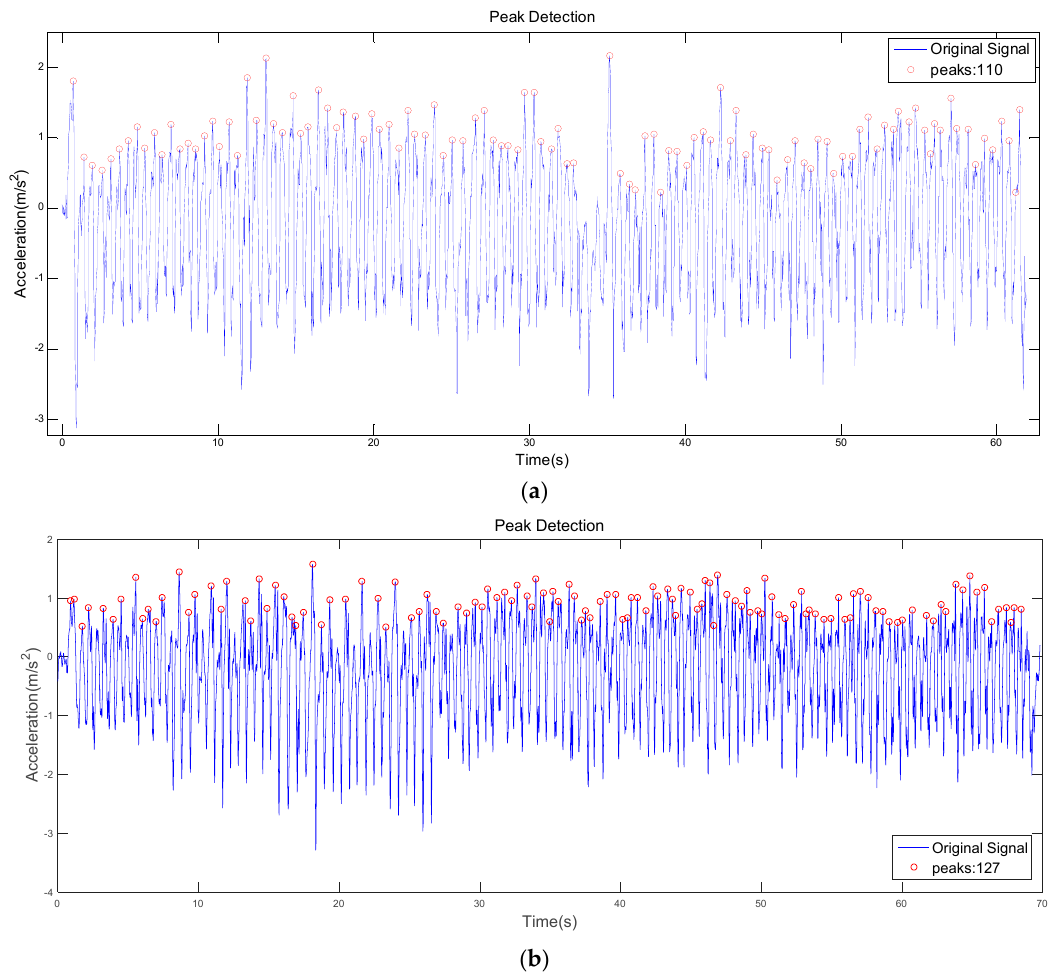
Figure 8. Peak detection of PDR: ( a ) the red circles indicate individual steps in scenario 1; and ( b ) the red circles indicate individual steps in scenario 2.